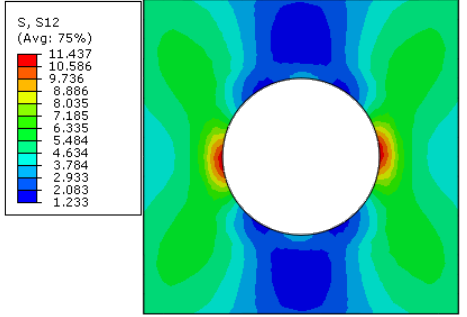
Figure 18. Intralaminar shear stress distribution pattern.